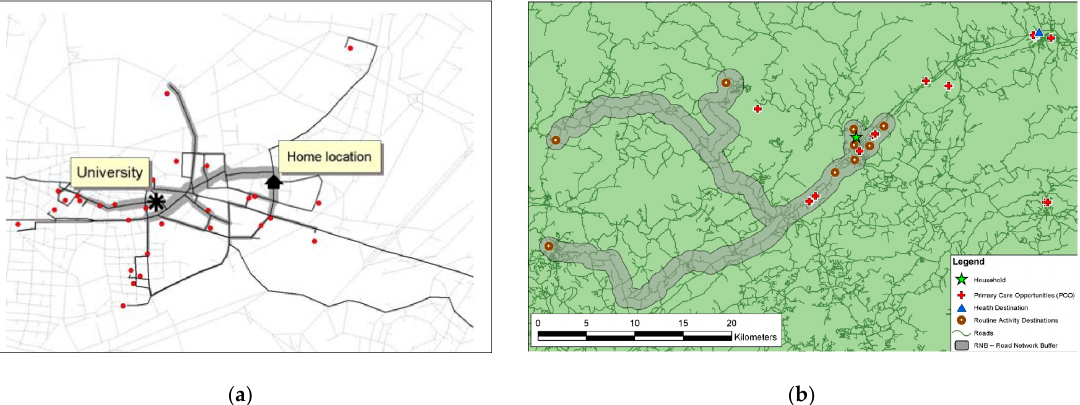
Figure 1. ( a ) Examples of shortest path network (SPN). Source: (Schönfelder and Axhausen, 2004) [24] and ( b ) road network buffer (RNB) measure. Source: [13].